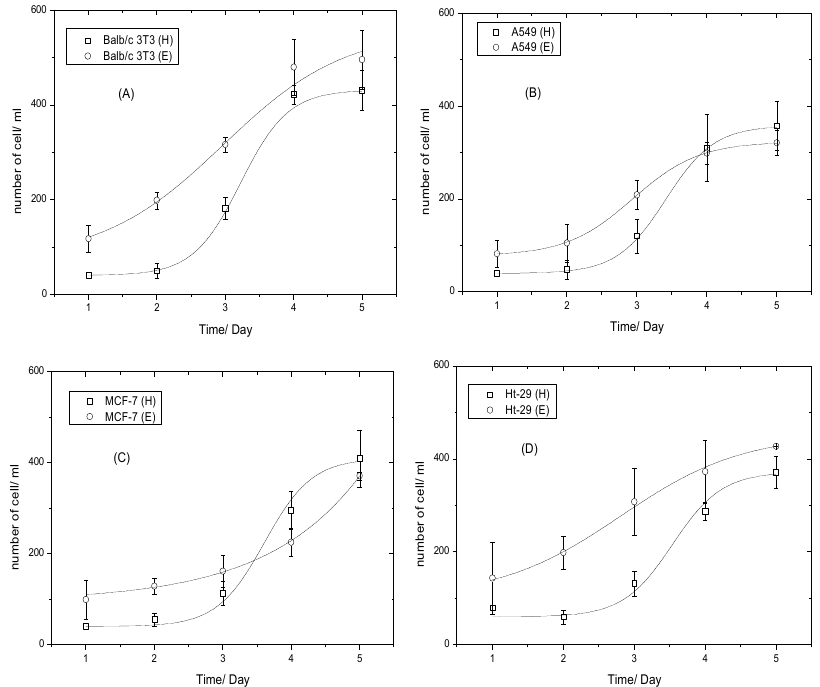
Figure 7. Logistic growth curves of ( A ) Balbc/3T3 cell lines; ( B ) A549 cell lines; ( C ) MCF-7 cell lines; and ( D ) Ht-29 cell lines, over five days. ( ◻ ) estimated cell number using linear equation of standard curve and, ( ⚪ ) accounted cell number using hemocytometer; all compared versus incubation time over five days. Data are expressed as the mean ± SD of measurements of three independent experiments.